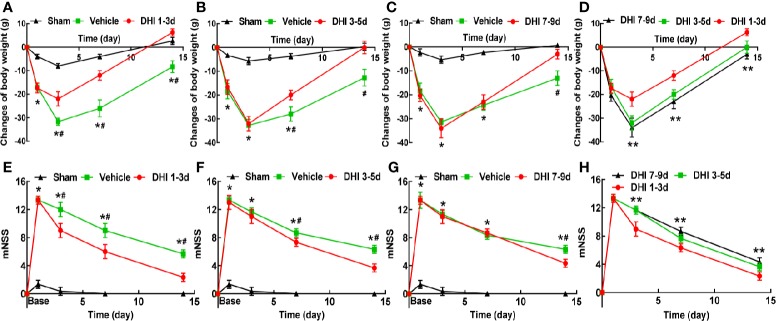
Danhong injection (DHI) treatment promotes the recovery of body weight and neurologic function. DHI treatment significantly promotes body weight recovery (A–C) and reduces modified neurologic severity score (mNSS, E–G) after intracerebral hemorrhage (ICH). (D) The administration of DHI on days 1–3 after ICH exhibits greater advantage in decreasing weight loss, when compared to the administration on days 3–5 or 7–9 (n = 12, P < 0.05). (H) DHI treatment on days 1–3 after ICH has a better effect on reducing neurological deficits, when compared to the treatment of DHI on days 3–5 or 7–9 (n = 12, P < 0.05). (*P < 0.05 vs. sham; #P < 0.05 vs. vehicle, **P < 0.05 vs. DHI 3–5 and 7–9 days).